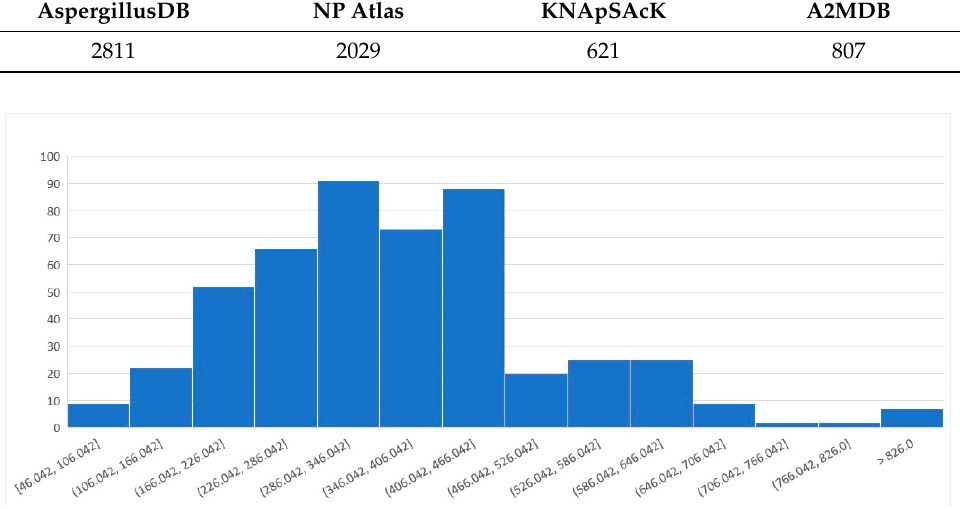
Figure 4. Monoisotopic masses distribution of the 491 compounds retrieved from the literature reference that were not present in NP Atlas or KNApSAcK. Y axis: number of compounds; X axis: m / z range. Table 3. Top 30 main classes from Classyfire.